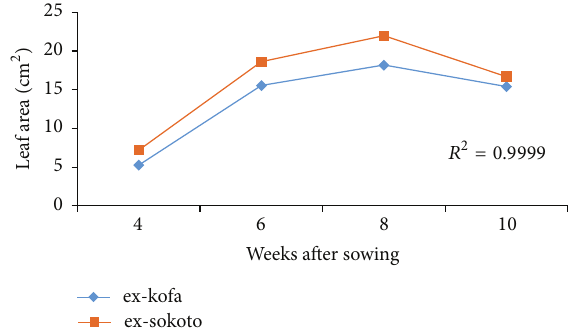
Figure 3: Significant ( 𝑝 < 0.05 ) growth trend of garlic varieties at 4, 6, 8, and 10 weeks after sowing on leaf